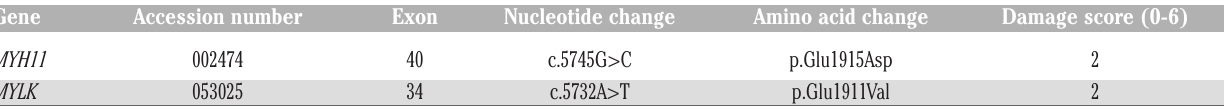
Table 2. Next generation sequencing variant results after Sanger confirmation in genes associated with thoracic aortic aneurysm and dissection. Gene Accession number Exon Nucleotide change MYH11 002474